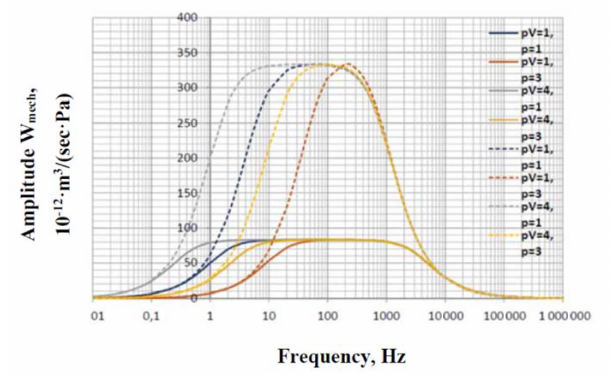
Figure 5. Spectrum of the mechanical transfer function. R h = 12 × 10 9 Ns ; the size of the channel is 3 × 3mm (solid curves). m 5 R h = 3 × 10 9 Ns ; the size of the channel is 6 × 6mm (dotted curves). m 5 R h ∼ 1 , where S el is the electrode net surface, S ch is the electrode S el channel surface, and S el ∼ S ch for the equal types of